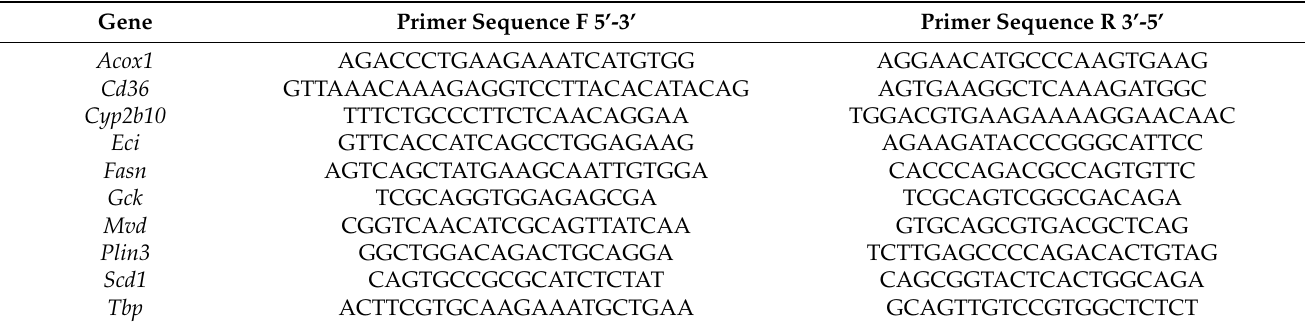
Table 1. Sequence of the primers used in